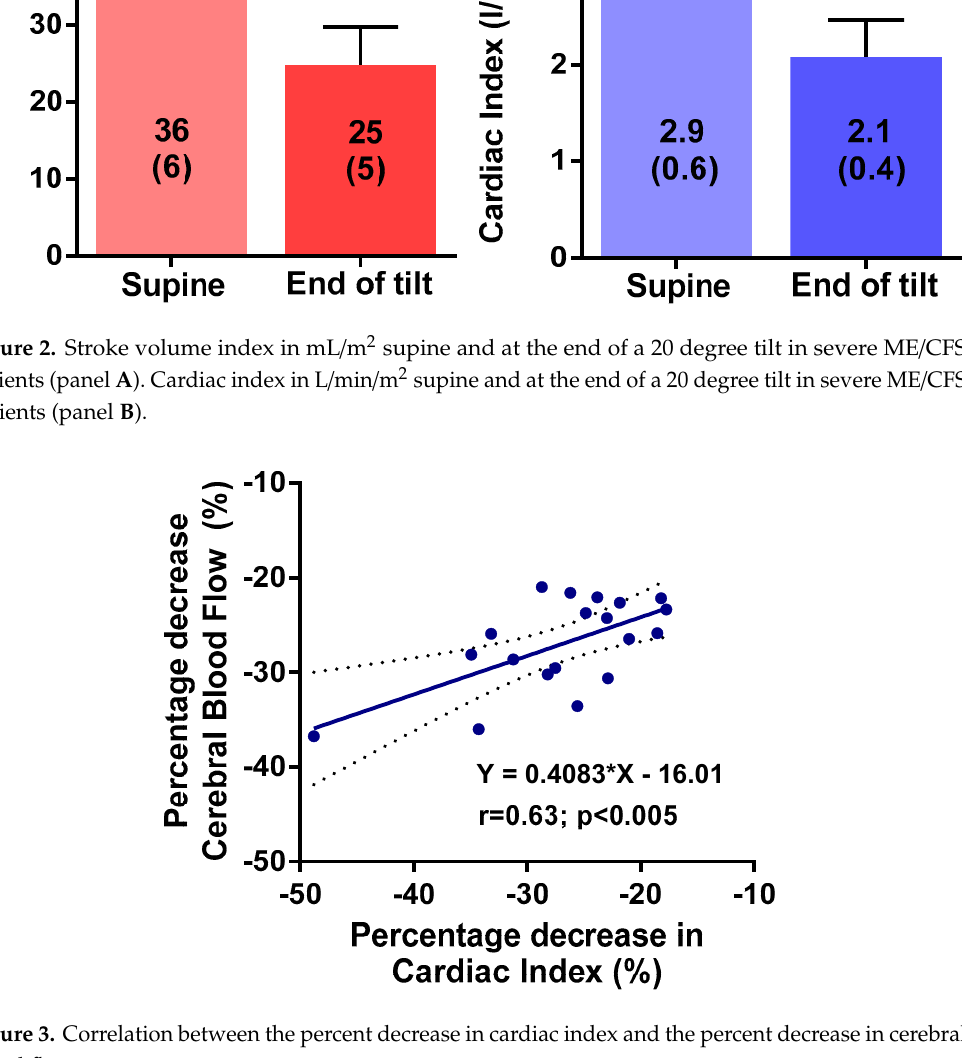
Figure 3. Correlation between the percent decrease in cardiac index and the percent decrease in cerebral blood flow.